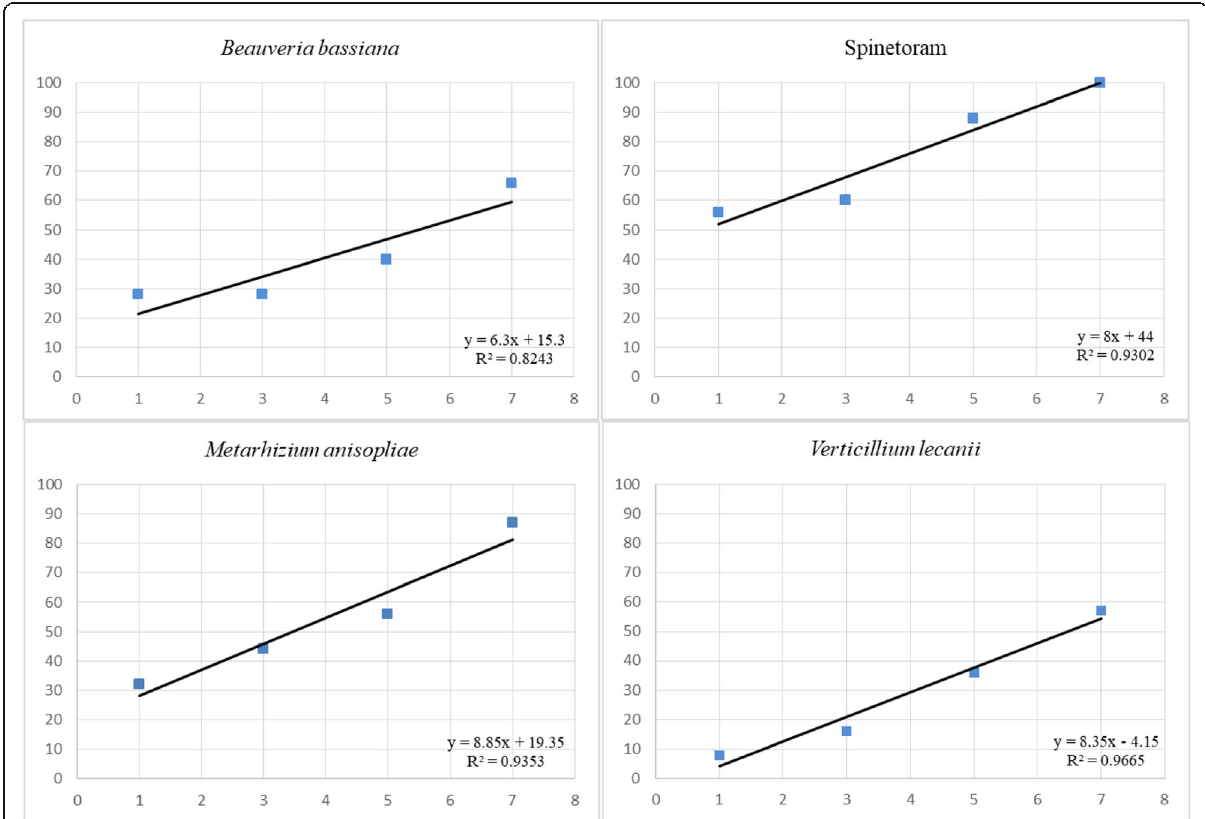
Fig. 1 The mean values LT 50 of bioinsecticides